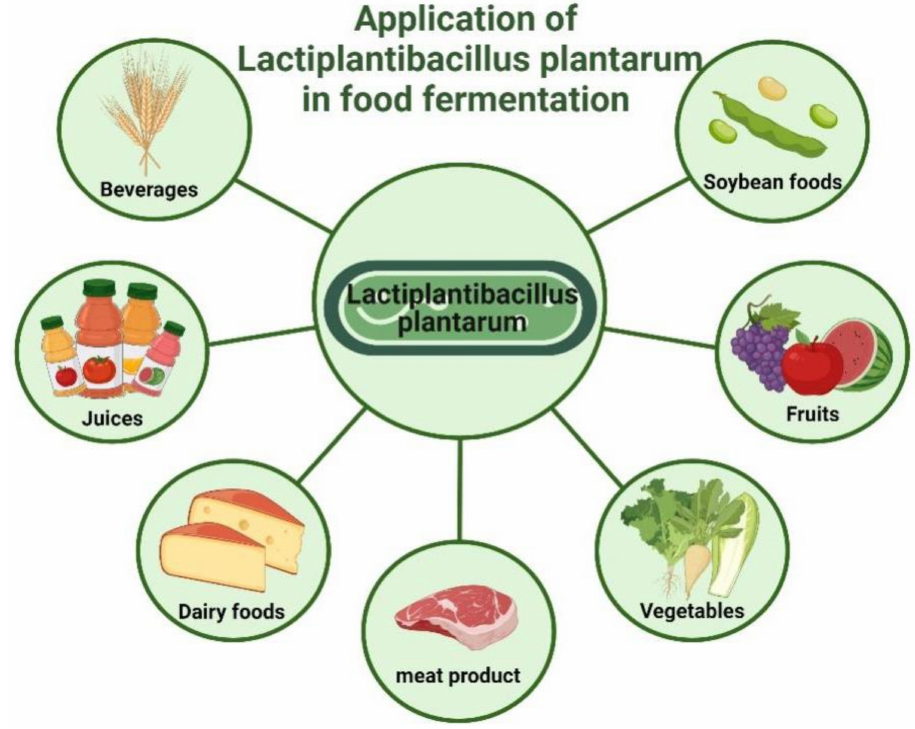
Figure 5. The application of Lactiplantibacillus plantarum in several different types of food. Lactiplantibacillus plantarum has been widely used as a fermenting strain in the production of a wide range of fermented foods. (Created with Biorender.com). Table 3. The effects of Lb. plantarum fermented foods in the prevention of different